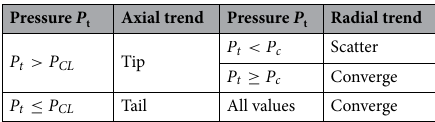
Table 8. Conditions for the motion trend of particles.